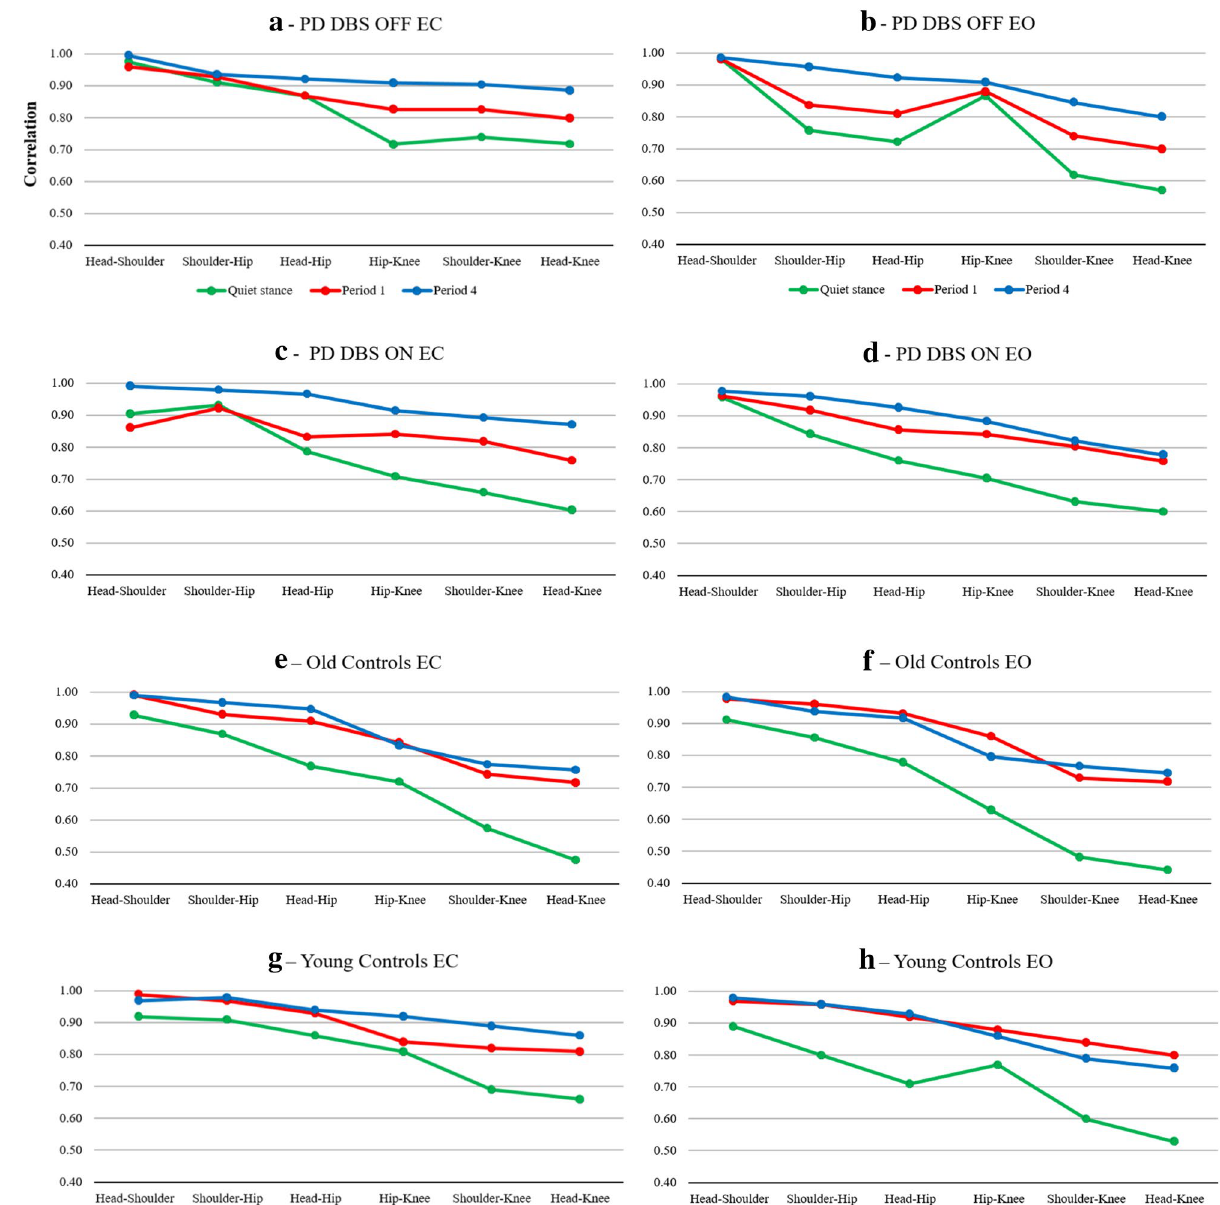
Figure 1. Body movement coordination (mean values) during different phases of the posturography tests for the PD subjects in DBS OFF mode ( a eyes closed; b eyes open), in PD subjects in DBS ON mode ( c eyes closed; d eyes open), in old controls ( e eyes closed; f eyes open) and in young controls ( g eyes closed; h eyes open). Note how both the older and younger controls retained the same posture in Periods 1 and Period 4 of balance perturbations, showing that they quickly adapt. The postural strategy in patients with PD took longer to finalize, mostly with DBS OFF and when standing with eyes